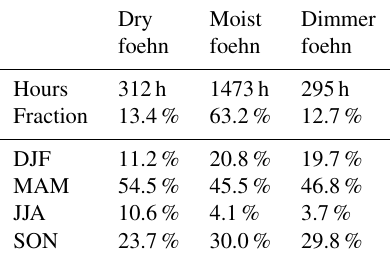
Table 1. Table providing the foehn hours for the main foehn types, their relative occurrence frequency and seasonality.